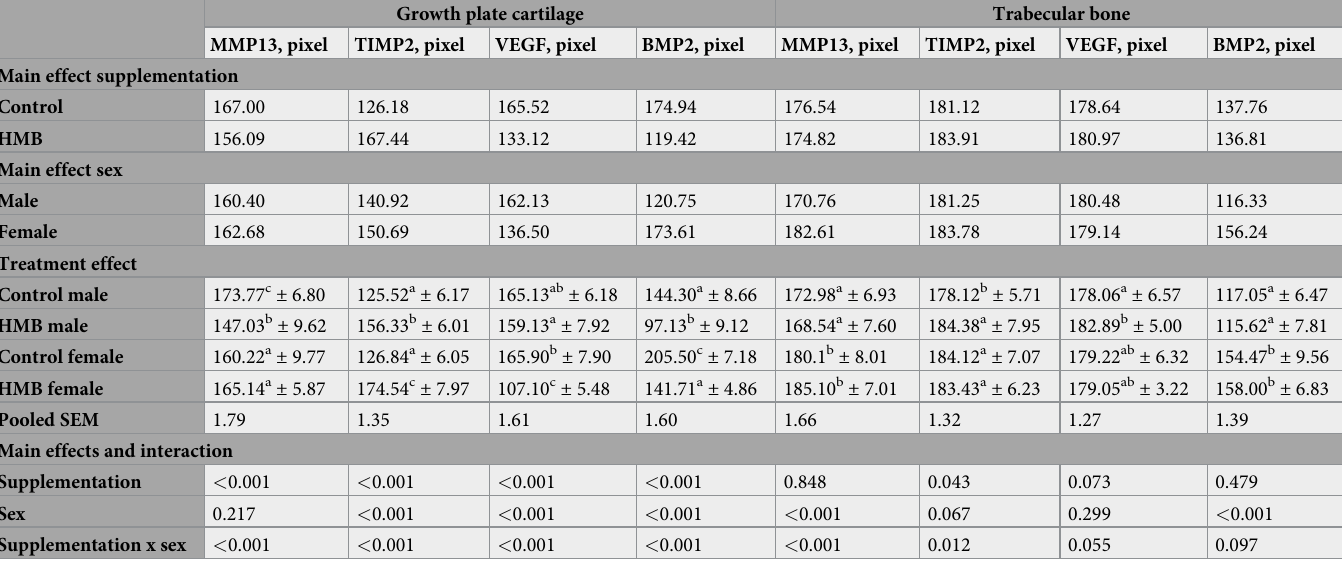
Table 8. Effect of maternal HMB treatment on the intensity of immunoreactions against MMP13, TIMP2, VEGF, BMP2 in the matrix between III and IV zone of growth plate cartilage as well as trabecular bone of the humerus in newborn